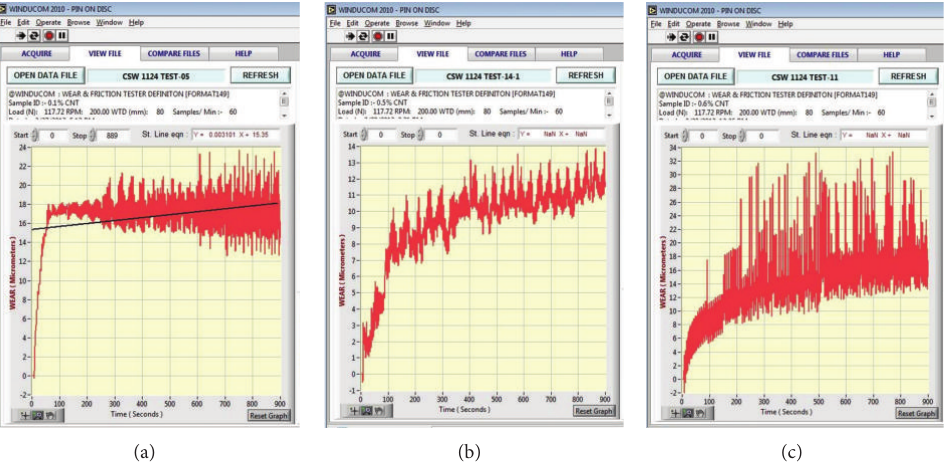
Figure 10: Amount of wear in (a) mineral oil + 0.1%wt MWNT, (b) mineral oil + 0.5% wt MWNT, and (c) mineral oil + 0.6% wt